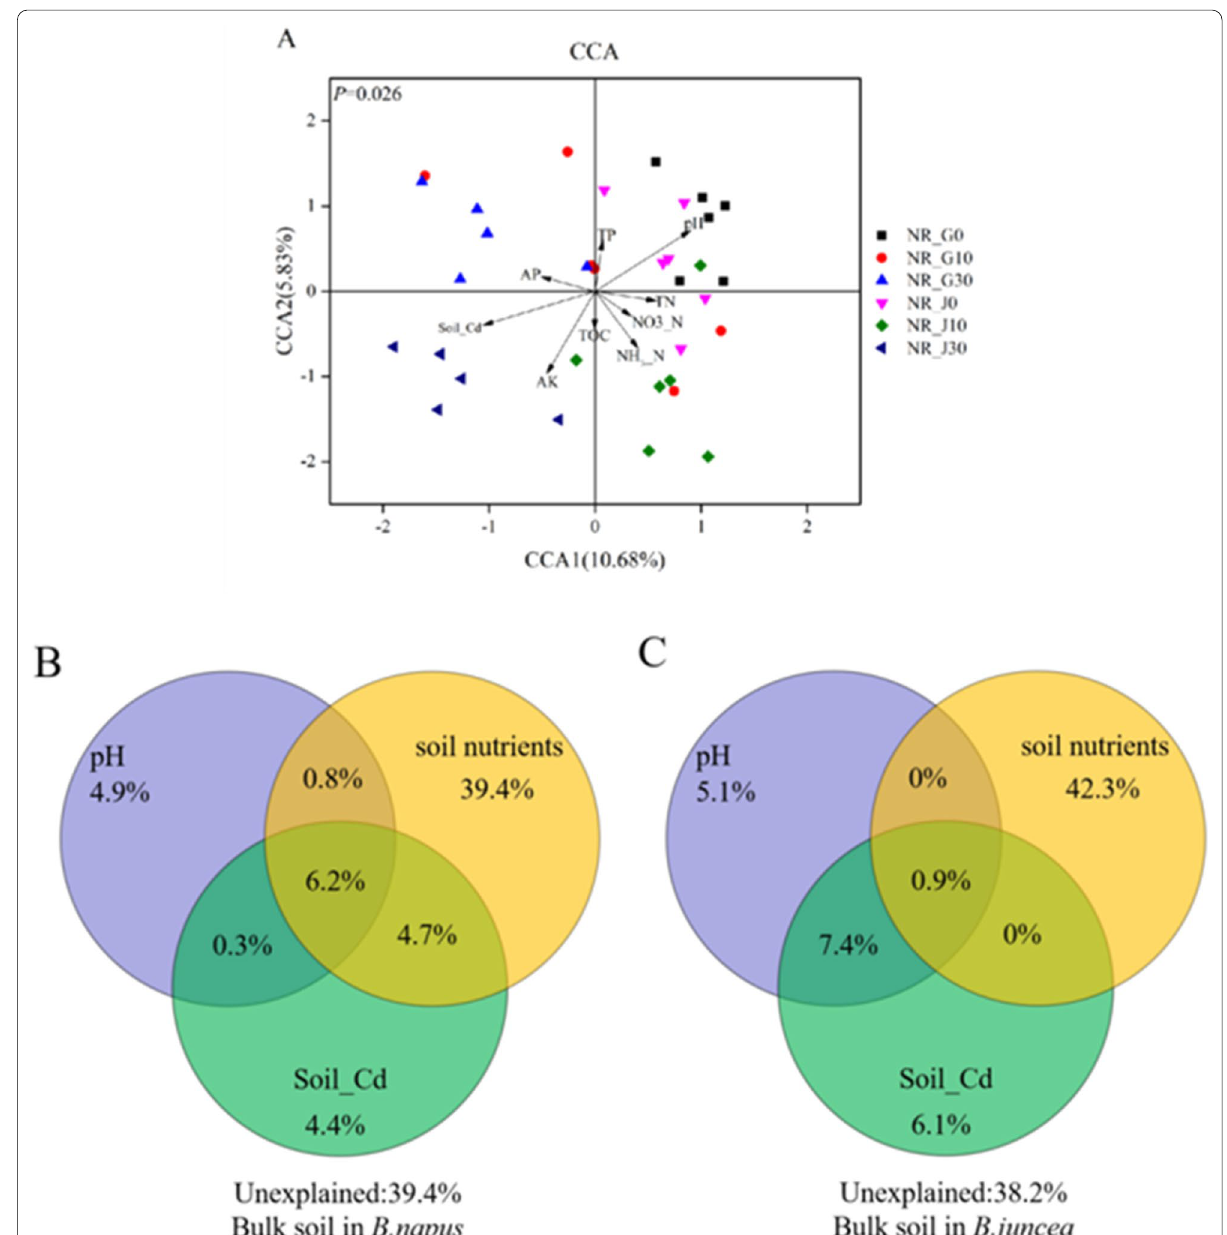
Fig. 6 Canonical correspondence analysis (CCA) on bulk soil bacterial communities with the environmental variables ( A ) and CCA-based variation partitioning analysis (VPA) of bacterial communities explained by environmental variables ( B , C